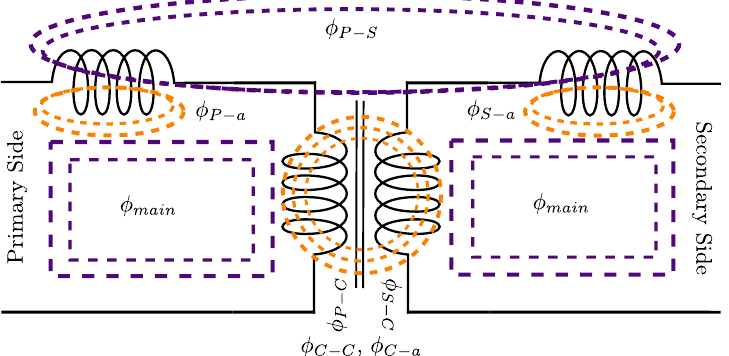
Figure 4. Flux leakage from core to air ( φ C − a ), core to core ( φ C − C ), primary winding to the core ( φ P − C ), secondary winding to the core ( φ S − C ), primary winding to air ( φ P − a ), secondary winding to air ( φ S − a ), primary winding to secondary winding ( φ P − S ), and main flux ( φ main